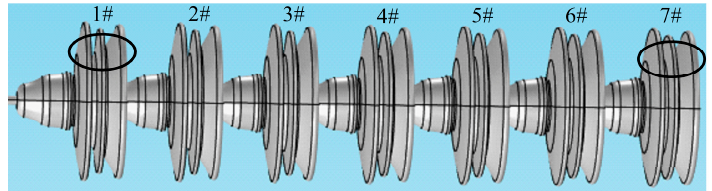
Figure 5. Insulator skirt number.